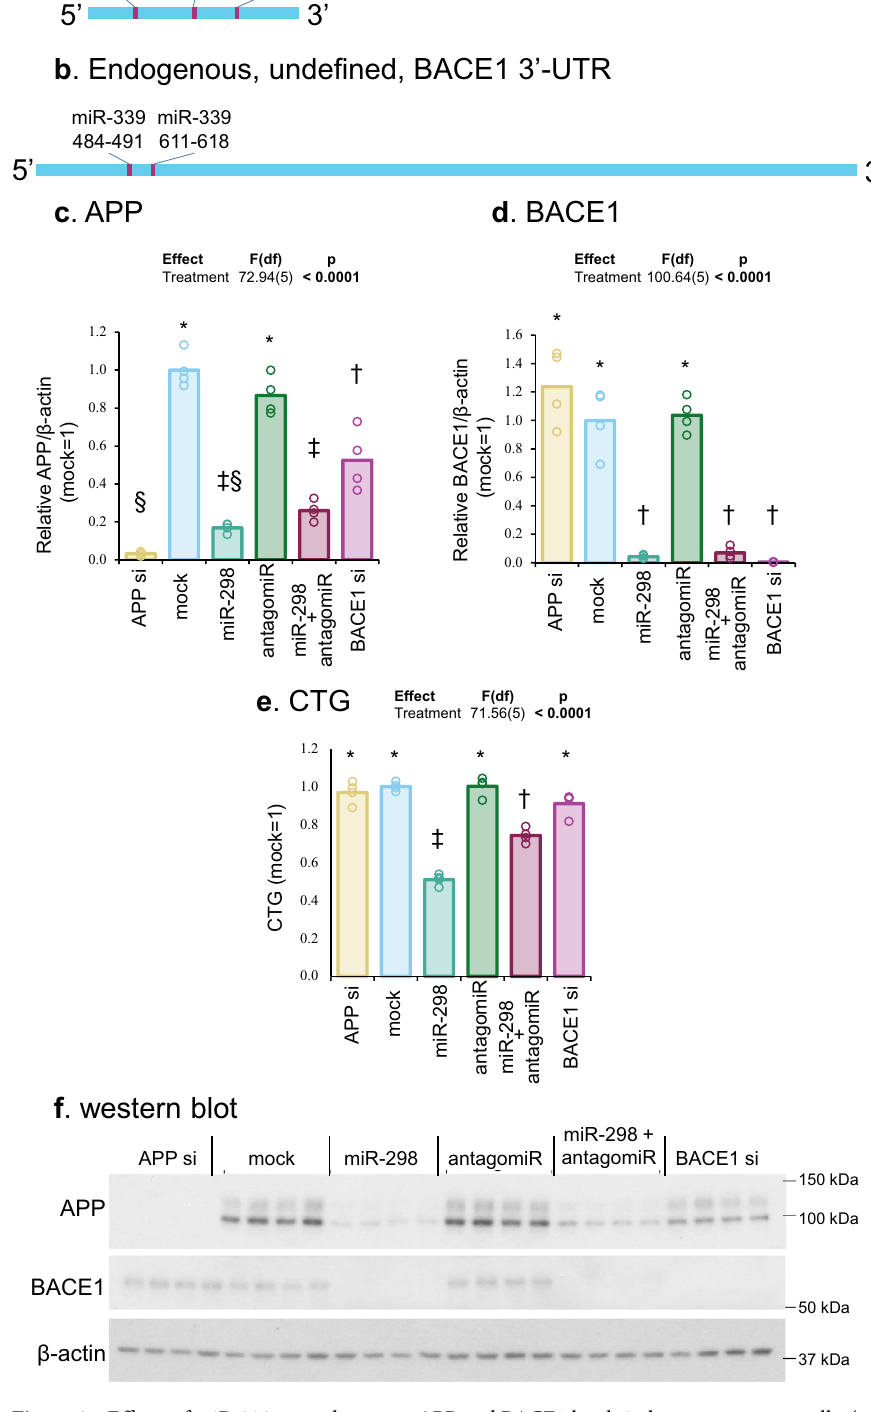
Figure 3. Effects of miR-298 on endogenous APP and BACE1 levels in human astrocyte cells. ( a , b ) Scale drawings of endogenous APP and BACE1 mRNA undefined 3 ′ -UTR with miR-298 binding sites. With full-length 3 ′ -UTR, where miRNAs can bind, miR-298 can reduce APP and BACE1 expression levels. ( c , d ) Densitometric analysis of APP and BACE1 levels. Each symbol represents a different statistical group. ( e ) Cell viability determined by CTG assay. ( f ) Western blotting of APP, BACE1 and β-actin. Results of pairwise comparison of all treatments is shown by symbols. Treatments sharing a symbol did not significantly differ (p < 0.05). "(ns)" indicates no significant pairwise